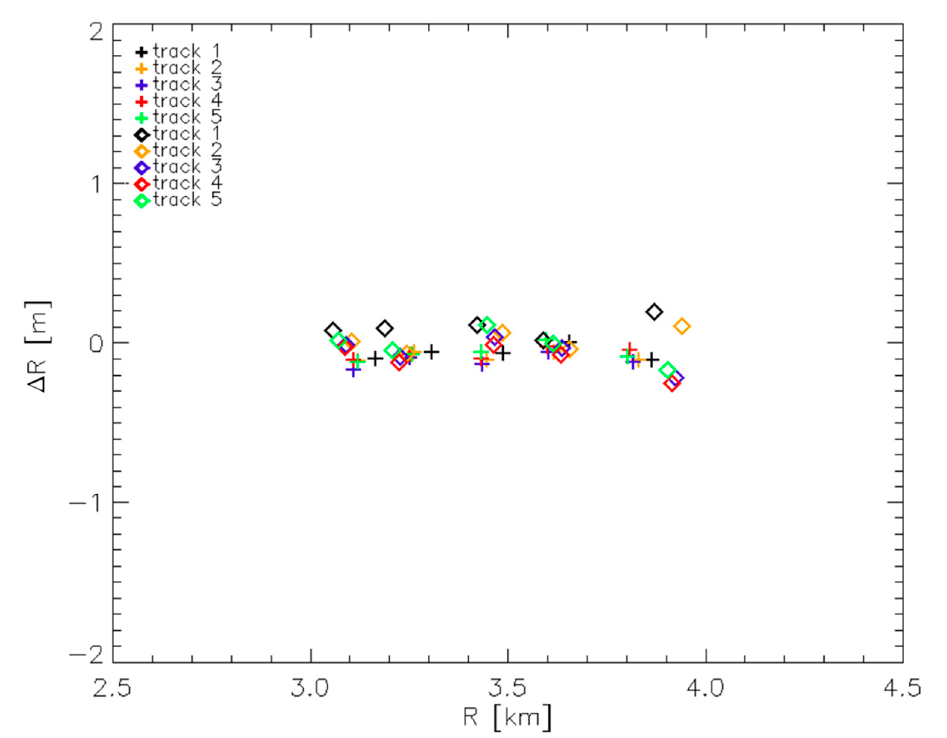
Figure 13. As Figure 5, but using the SAR images relevant to the 2018 (crosses) and 2019 (diamonds) datasets, all focused by using the FSR estimated in the Experiment 5.